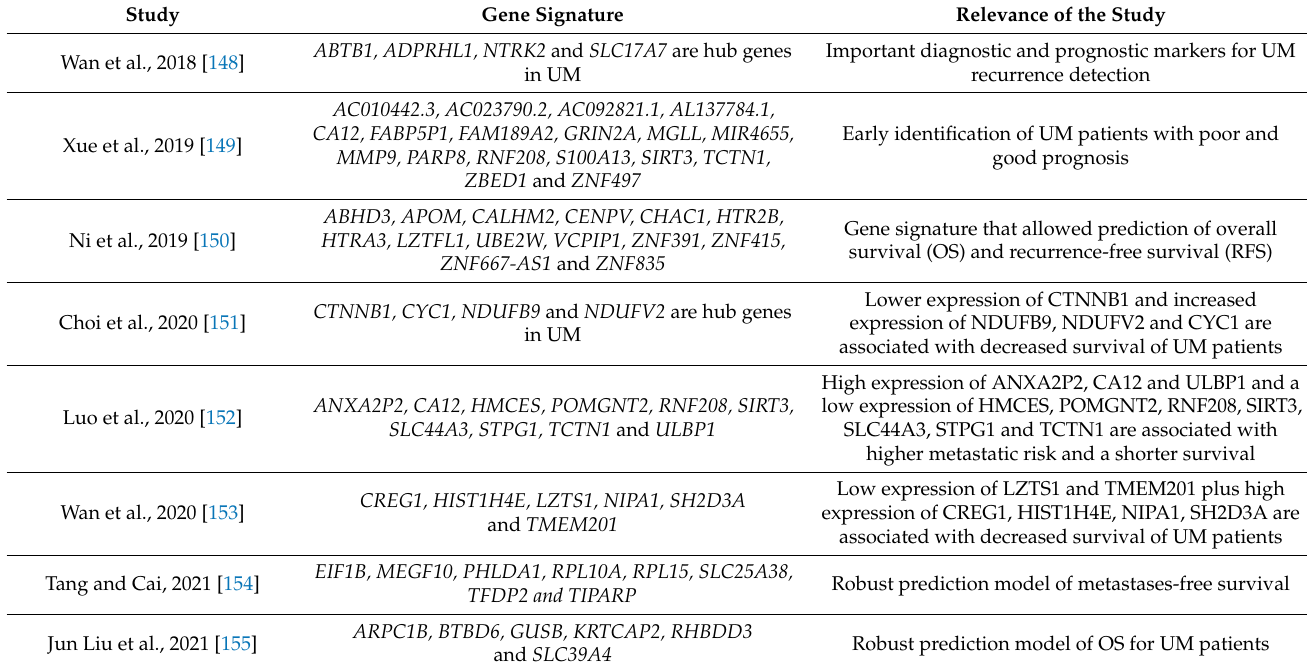
Table 3. Novel promising prognostic gene signatures in primary uveal melanoma. The novel gene signatures for uveal melanoma described below were published in the past three